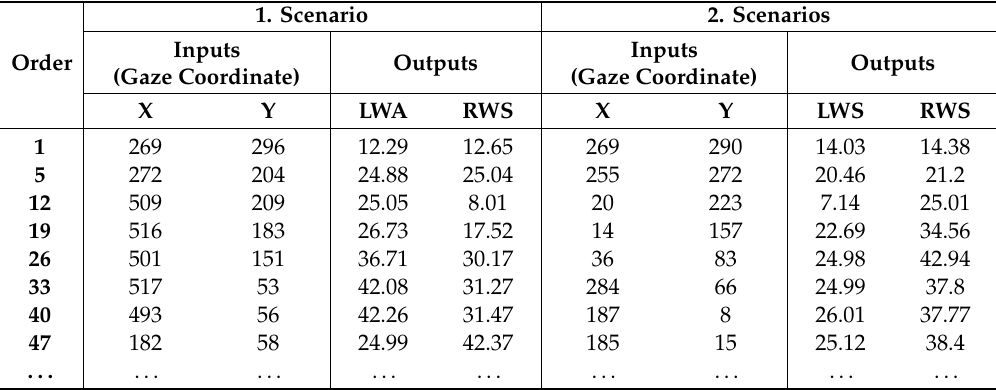
Figure 18. The e ff ectiveness of the fuzzy rules and suitability of the fuzzy controller on collision-free behavior is shown in Figure